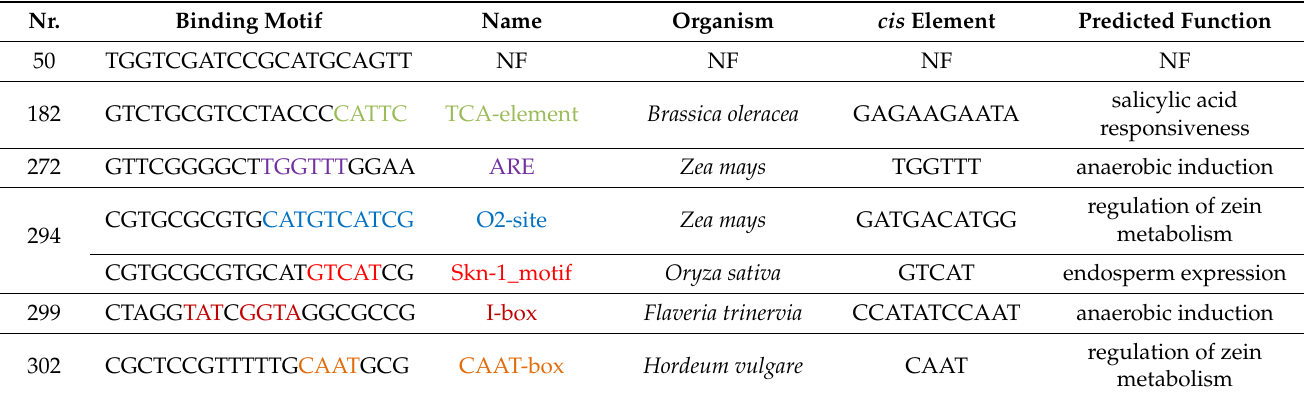
Table 1. Hexanucleotid sequences recovered during the DPI-ELISA assay using recombinantly expressed OsDLKT. NF: No cis element was found. The active sites were predicted via PlantCare and highlighted in different